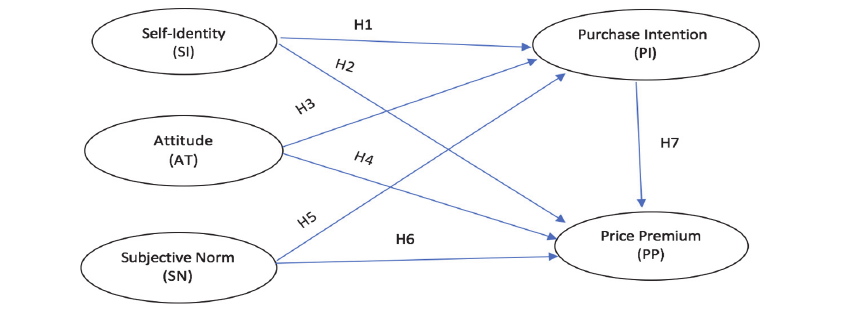
Fig. 1. A conceptual